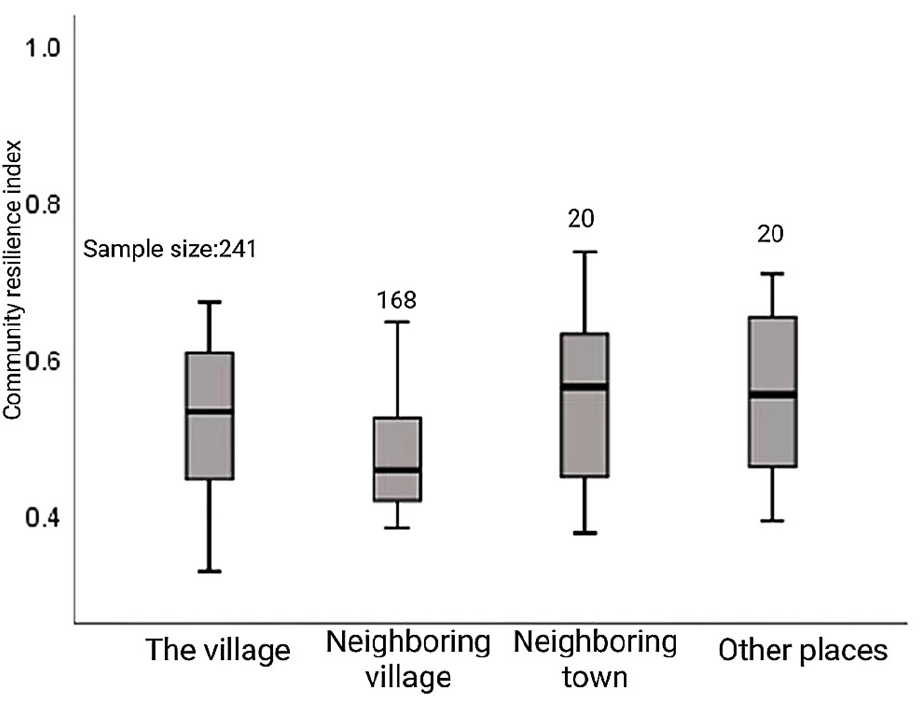
Figure 7. Community resilience index of relocated households in different relocated areas.